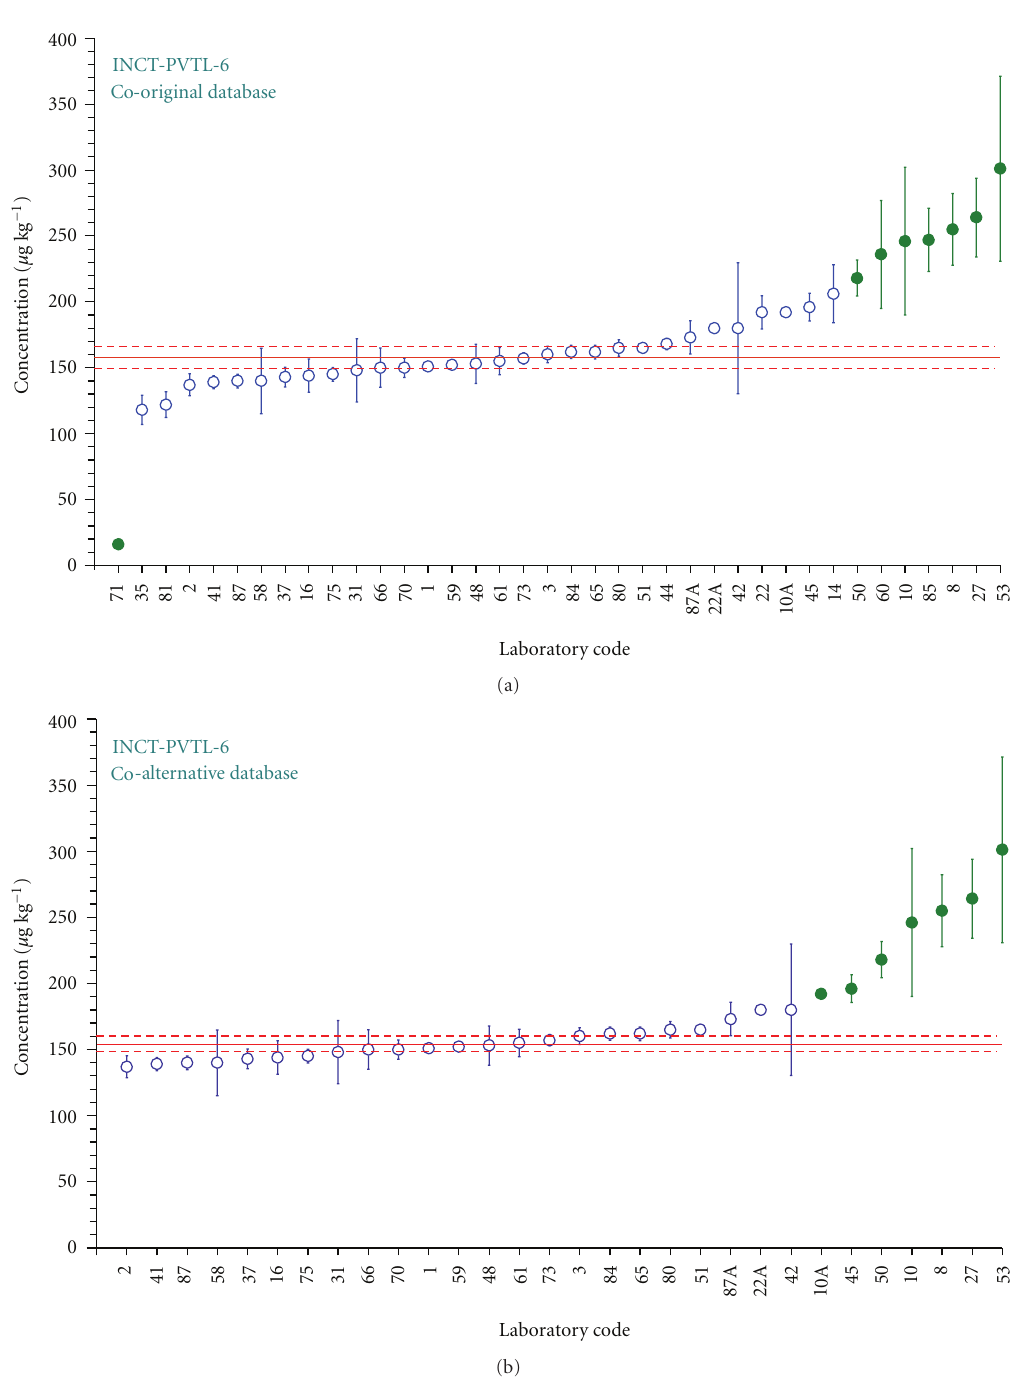
Figure 5: Z-shaped plots for Co in INCT-PVTL-6 while processing the original (a) and alternative databases (b). Laboratories qualified as outliers are marked with filled symbols; a solid horizontal line represents the overall mean and dashed lines confidence